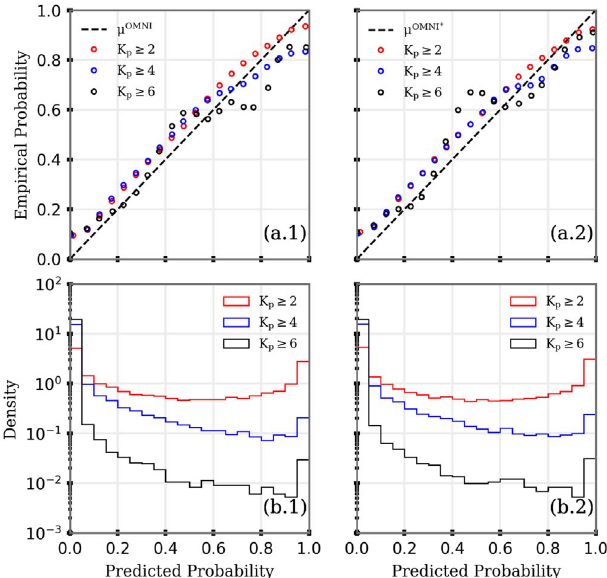
Fig. 13. Reliability diagram showing observed frequency of a geomagnetic storm (for K p (cid:1) 2,4, and 6) plotted against the forecast probability of geomagnetic